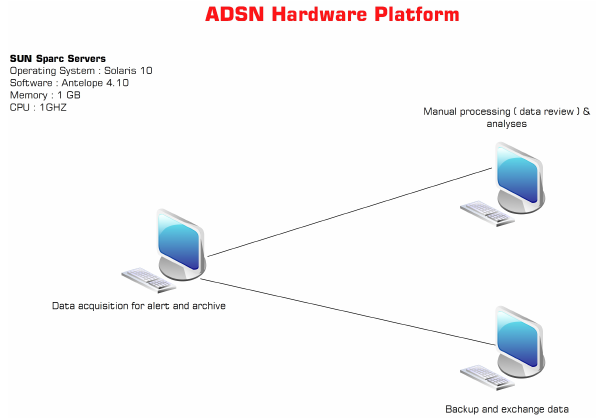
Fig. 4. The Current Hardware Plateform with the SUN Sparc Sta-